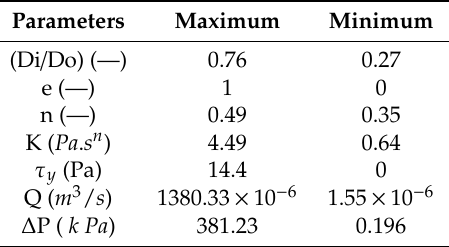
Table 3. Range of experimental